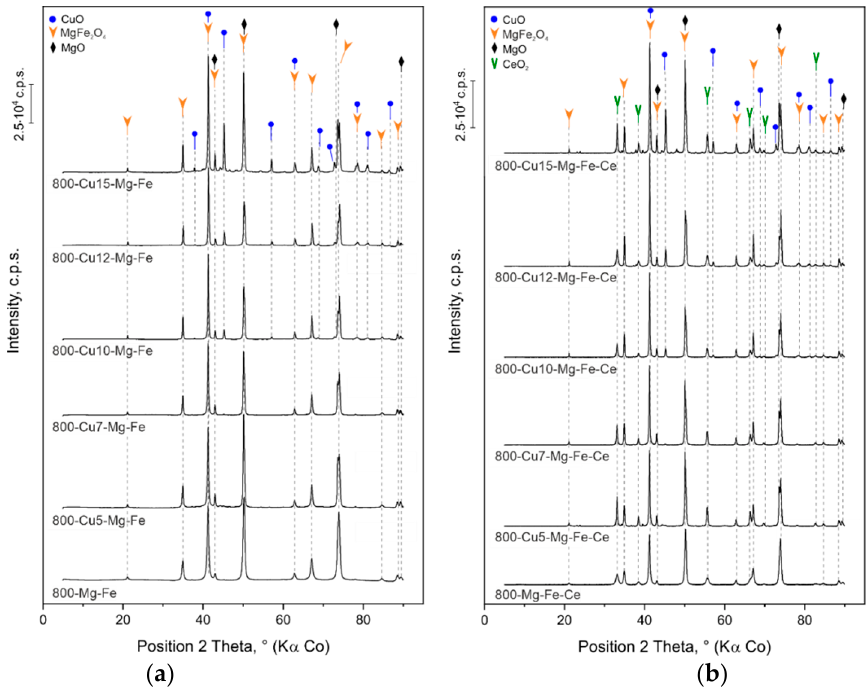
Figure 1. Phase composition of mixed metal oxides ( a ) 800-Cu-Mg-Fe-O and ( b ) 800-Cu-Mg-Fe-O-Ce.